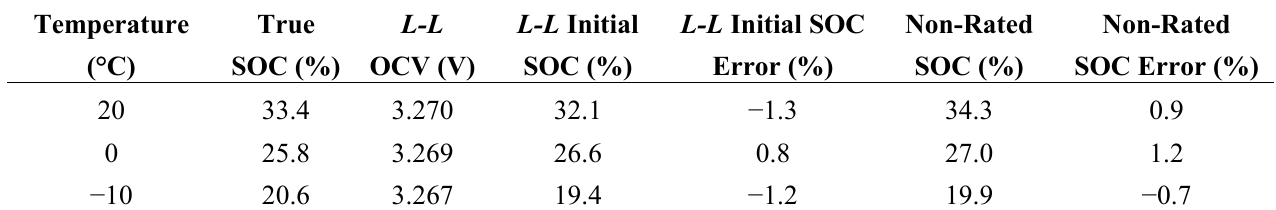
Table 8. The non-rated SOC, L-L non-rated initial SOC, and SOC error at 20, 0, and − 10 °C (point